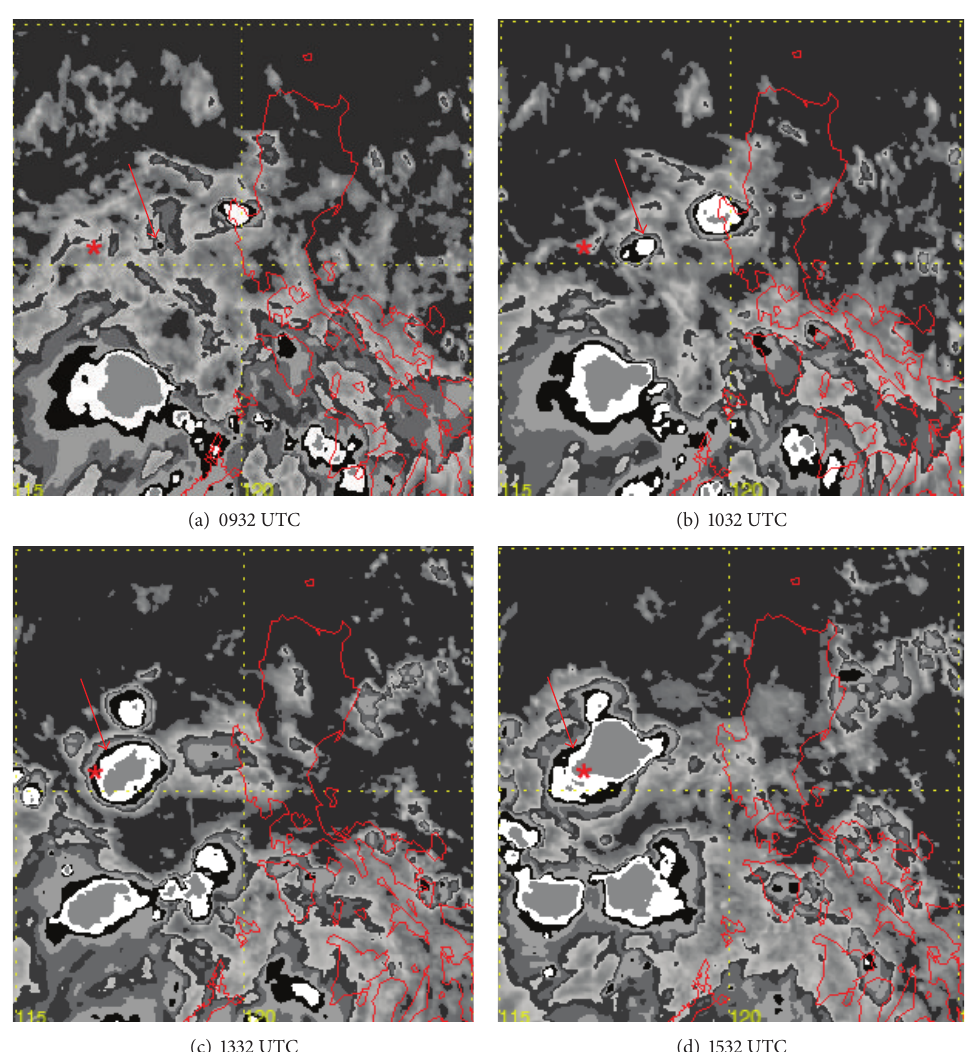
Figure 3: Infrared satellite pictures from MTSAT over the area of severe turbulence before and after the event. The convection under consideration is highlighted by a red arrow. The asterisk shows the location of the severe turbulence event. The satellite images are shown using the colour scale of Dvorak